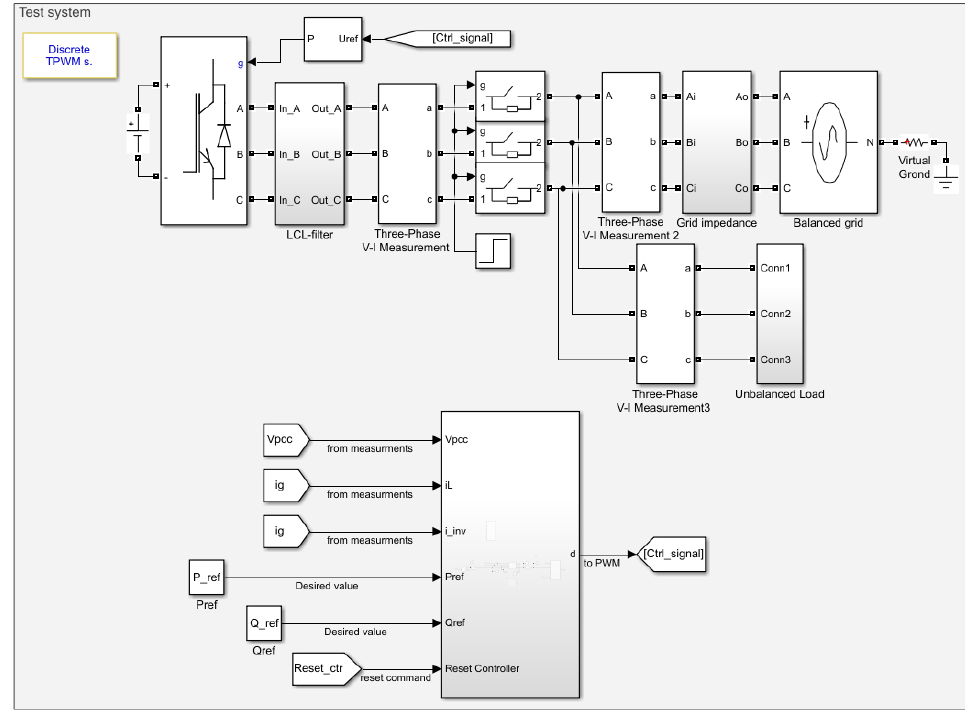
Figure 9. System’s Simulink model.